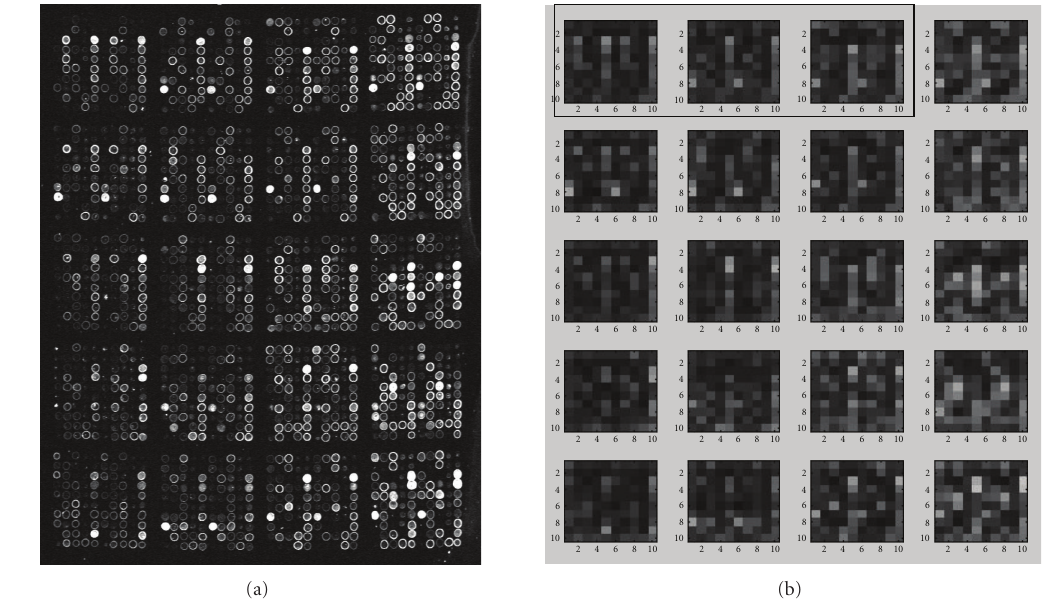
Figure 6: (a) Fluorescence image of a sampled microarray of cDNA, Cy3 dye, and Cy5 dye mix (only Cy5 red fluorescence is shown) [19]. Each cluster consists of a 10 × 10 grid of sample dots. Each dot corresponds to the location of a cDNA probe to which mRNA from the cells of interest have been bound. (b) Pixellated images of the clusters from the left microarray photo. Each cluster consists of a 10 × 10 pixel array that mimics a normalized biosignature pattern. The first three randomly picked desired patterns (enclosed in the solid line frame) have indices (0, 0), (0, 1), and (1, 0), accordingly. The rest unwanted patterns share index (1, 1).